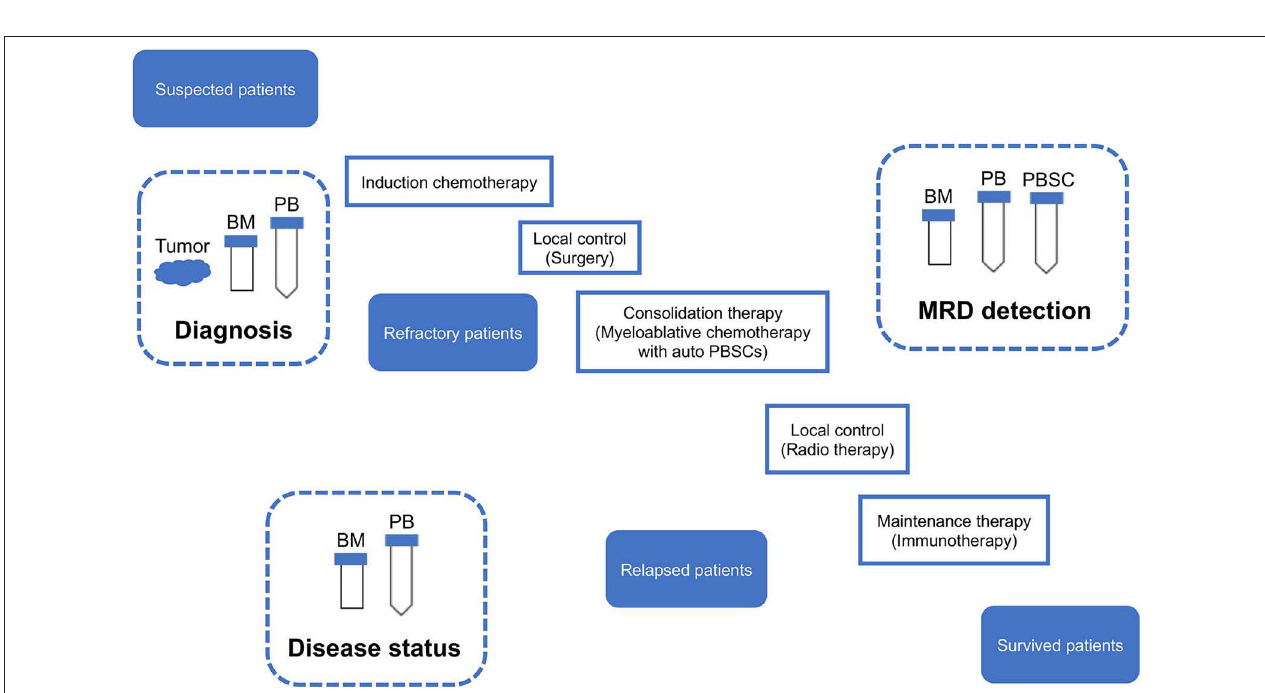
FIGURE 5 | Sampling from neuroblastoma patients. MRD, minimal residual disease; PB, peripheral blood; PBSC, peripheral blood stem cell; BM, bone marrow; IC, immunocytology.